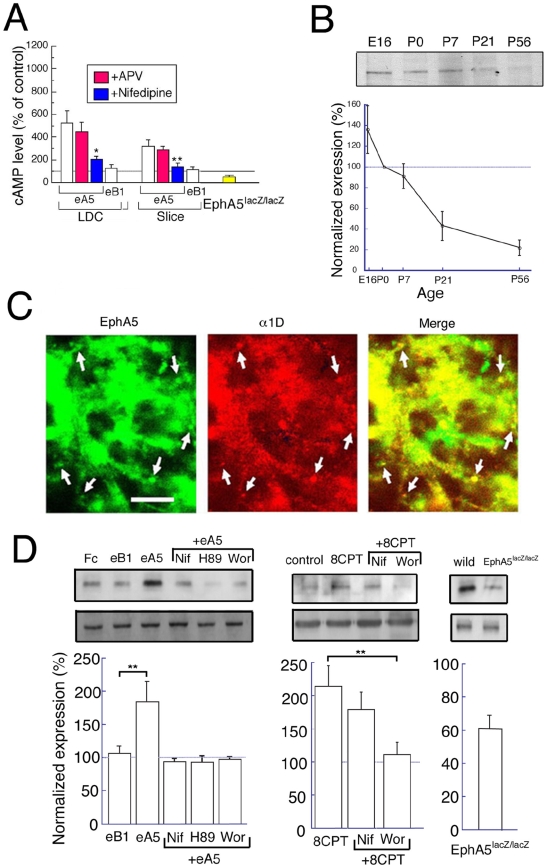
Intracellular signal transduction by EphA5.(A) The intracellular level of cAMP was measured for LDC, for slice culture with or without eA5 or eB1 with or without APV (50 µM) or nifedipine (20 µM)(white, red, blue bars) and for EphA5 lacZ/lacZ at P4 (yellow bar). The data from EphA5 lacZ/lacZ were normalized to wild-type, whereas the other data were normalized to control without drug. n = 4, all for LDC, slices and in vivo. (B) Western blot analysis was performed for the developmental expression of α1D in hippocampal tissues at the indicated ages (upper panel). n = 4. (C) Double immunostaining with anti-EphA5 and anti-α1D antibodies was performed for hippocampal neurons in culture for 4 DIV (upper panel). Arrows indicate representative colocalization of EphA5 and α1D in puncta in proximal neurites. Bar indicates 10 µm. (D) For measurement of cdc42 activity, hippocampal neurons were cultured for 6 DIV with or without the indicated drug(s), and hippocampal tissues from EphA5lacZ/lacZ and wild-type mice at P5-6 were dissected. Then, activated and total cdc42 were measured as shown in Methods. Upper and lower panels indicate representative blots of activated cdc42 and total cdc42, respectively. Activated cdc42 values are normalized to the level of total cdc42. n = 5–6 and 4, for LDC and in vivo, respectively. ** indicate significance at P less than 0.05.